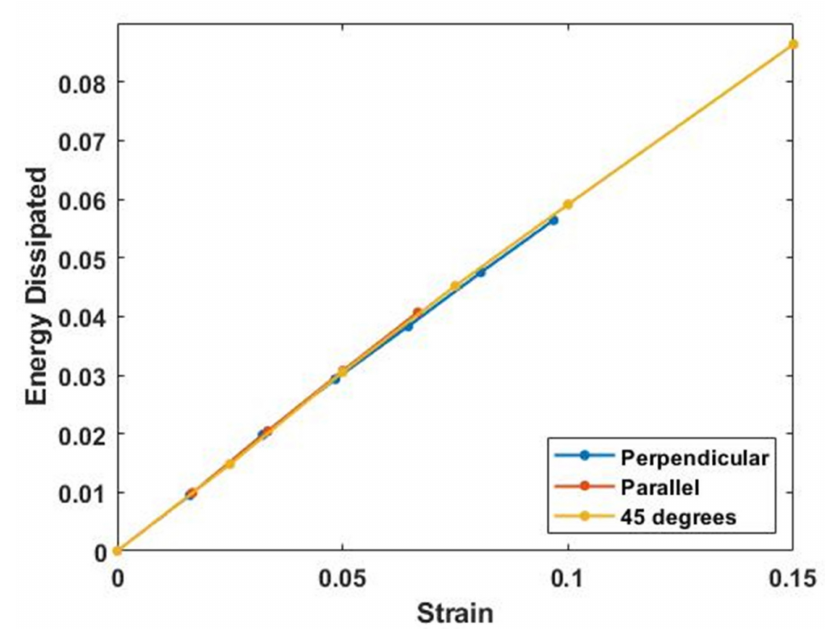
Figure 7. Energy dissipated by skin calculated from the area of the % of elastic modulus versus strain curve (with units of MPa) in vivo as a function of strain at 30 Hz (the lowest frequency that VOCT measurements can be made) and collagen fiber orientation. Note the energy dissipated appears similar for all collagen orientations and only depends on the degree of stretch. Parallel measurements were made at 0 ◦ while perpendicular ones were made at 90 ◦